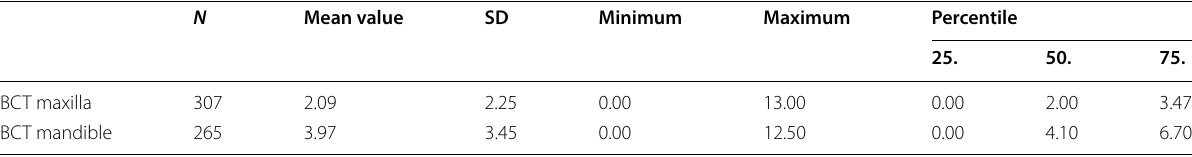
Table 5 Buccolingual height discrepancy of edentulous region in mm